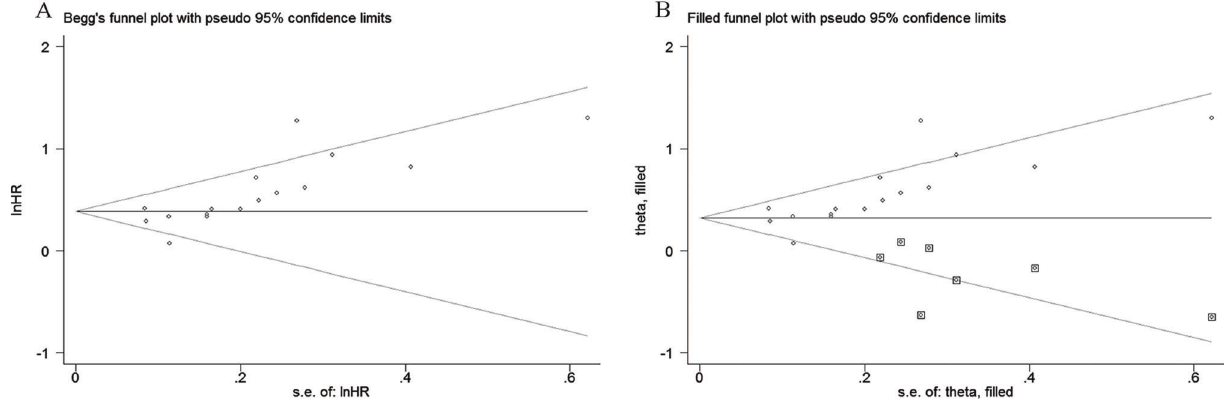
Figure 8 - Begg ’ s funnel plot of evaluating the publication bias for OS (A). Adjusted Begg ’ s funnel plot from the trim-and-fill method for assessing the publication bias for OS